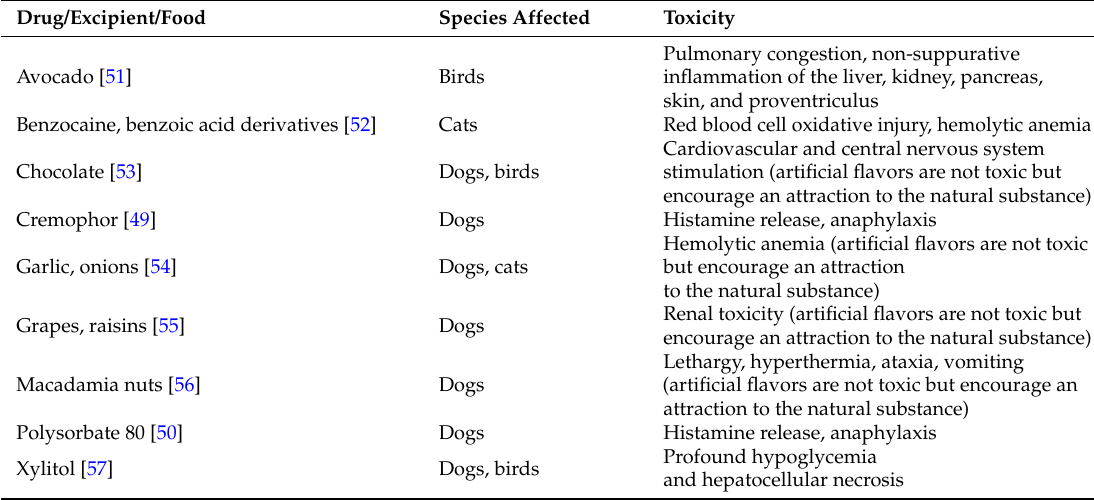
Table 1. Toxic drugs, excipients and foods by species and resultant